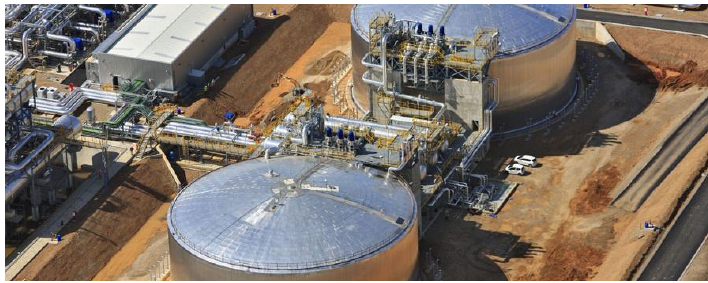
Figure 1. Molten salt tanks for storing thermal energy in the solar plant “La Africana” Granada.